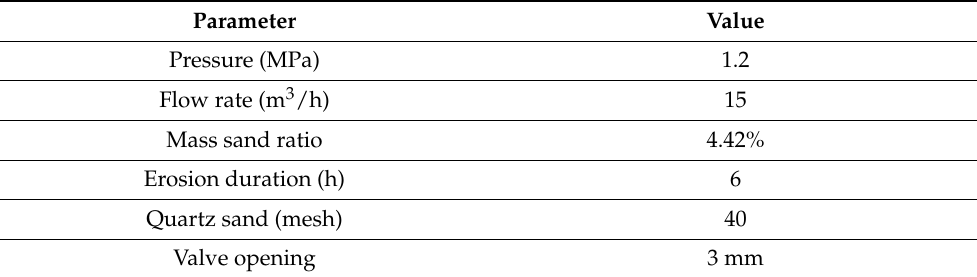
Figure 2. Schematic of valve erosion test design. (Black arrow indicates fluid flow direction). Table 4. Valve erosion test